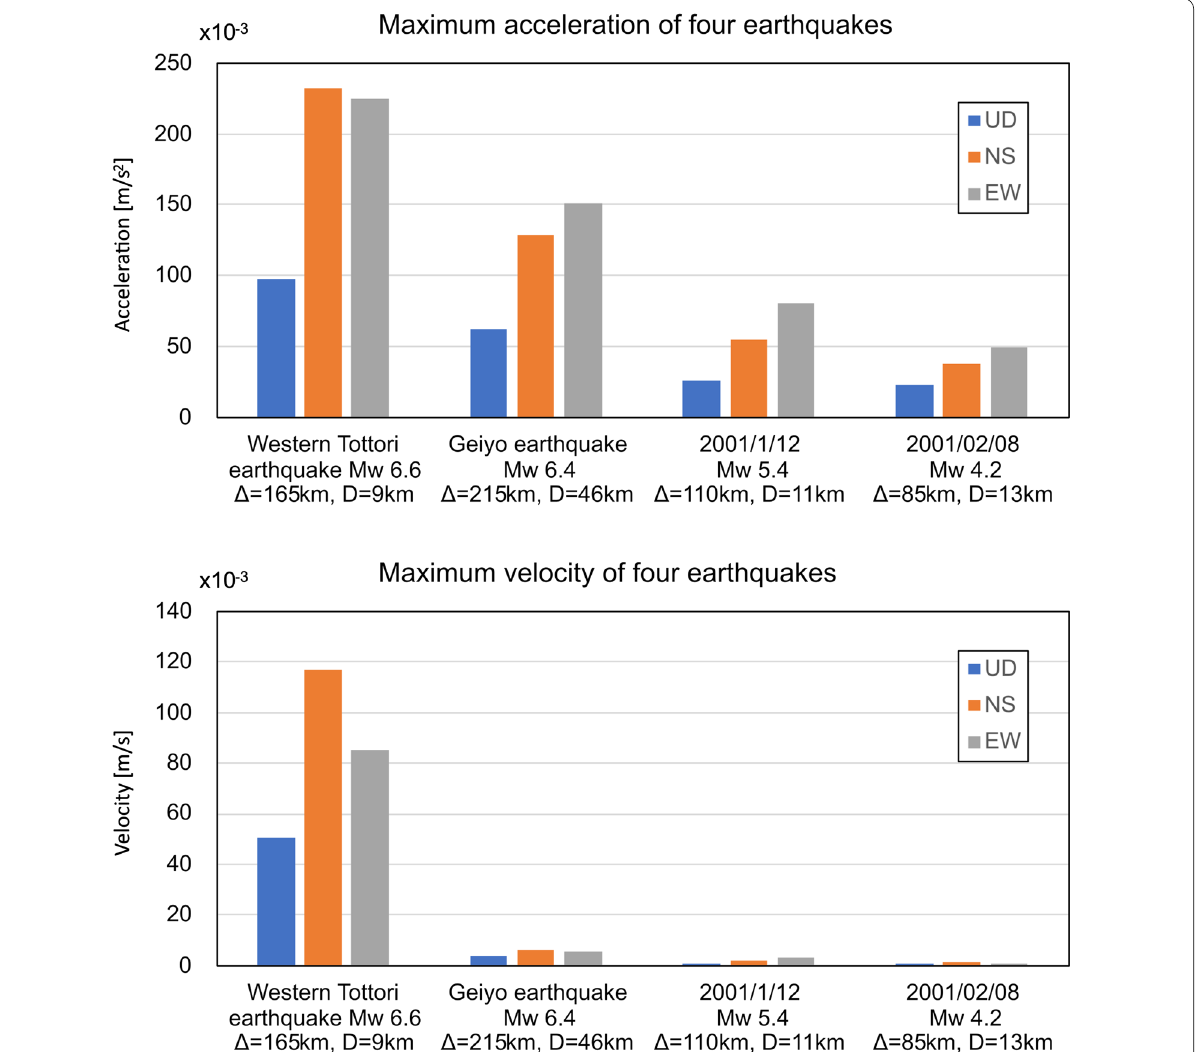
Fig. 7 Maximum acceleration and maximum velocity at four earthquakes with relatively large ground motion. The maximum acceleration and velocity were calculated by averaging of maximum amplitude of acceleration and velocity waveforms at four accelerometers in the Awaji Island, respectively. The velocity waveform was calculated from acceleration using a high-pass filter with a cut-off frequency of 0.1 Hz. (cid:31) and D in the last lines in captions of each earthquake indicates epicenter distance and depth of the earthquake,